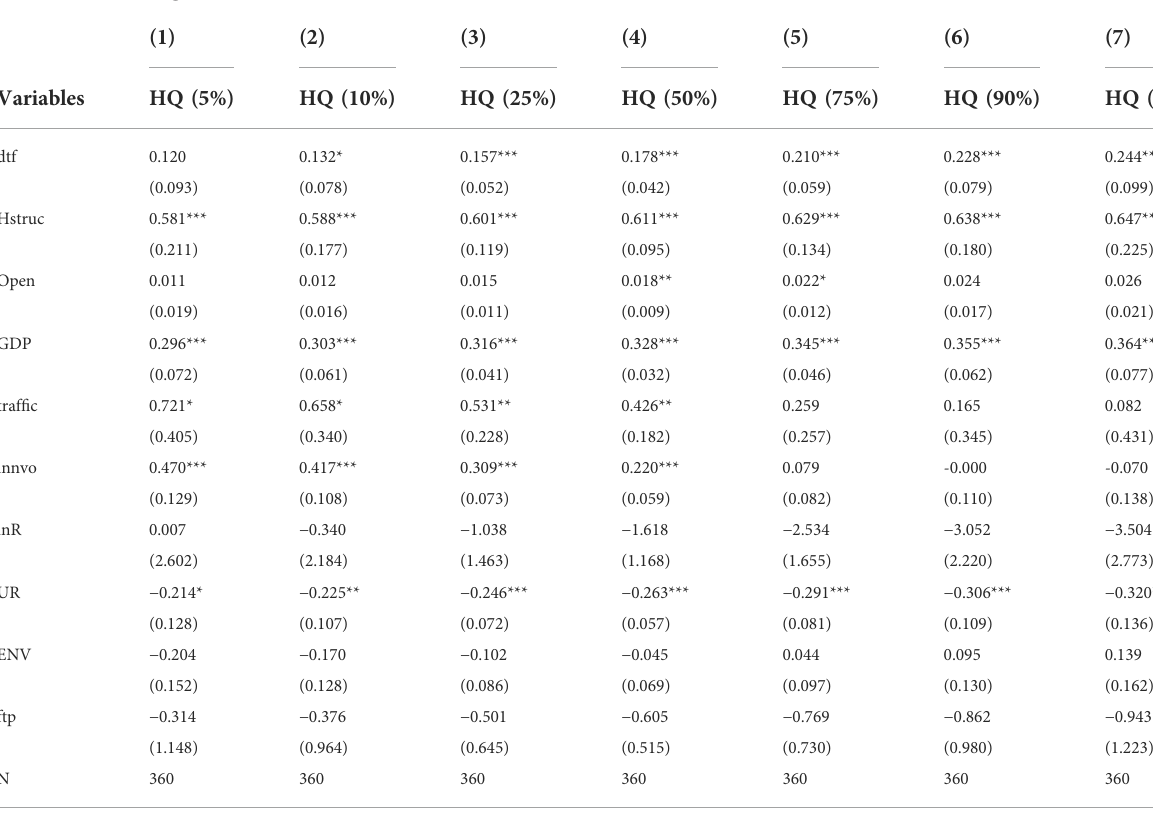
TABLE 17 Quantile regression.